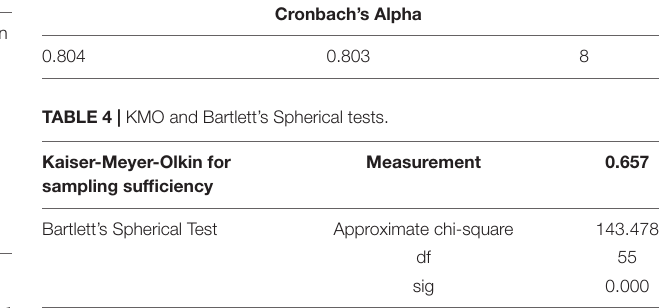
TABLE 2 | Knowledge points and thinking levels of test questions. Question No.